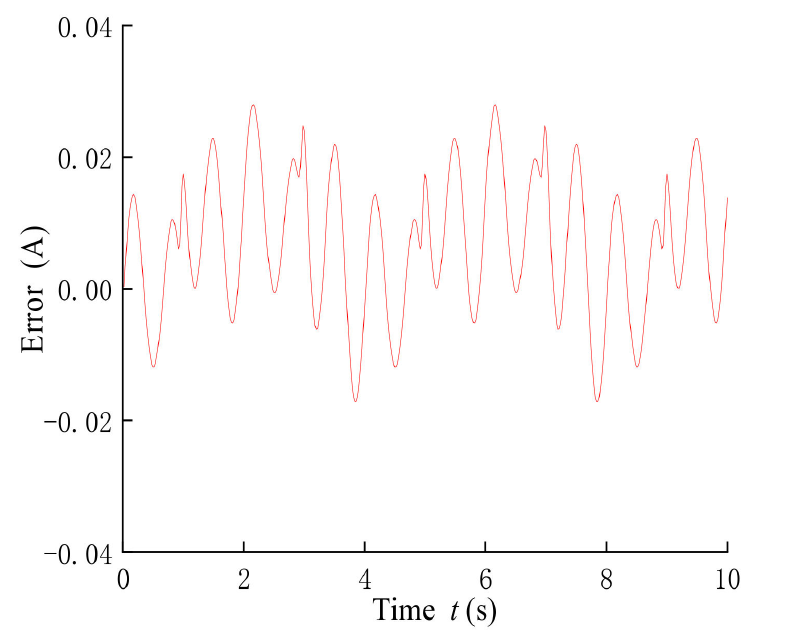
Figure 14. Error curve between sample value and fitted value.